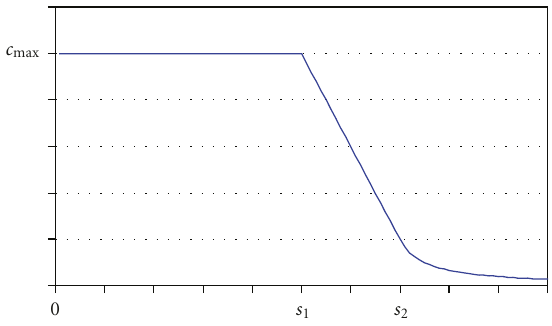
Figure 10: Decreasing function used as adaptive function in the di ff erent filters. It has three parts: a constant one for small prediction errors, a linear one in a transition area, and a vanishing one for large prediction errors.